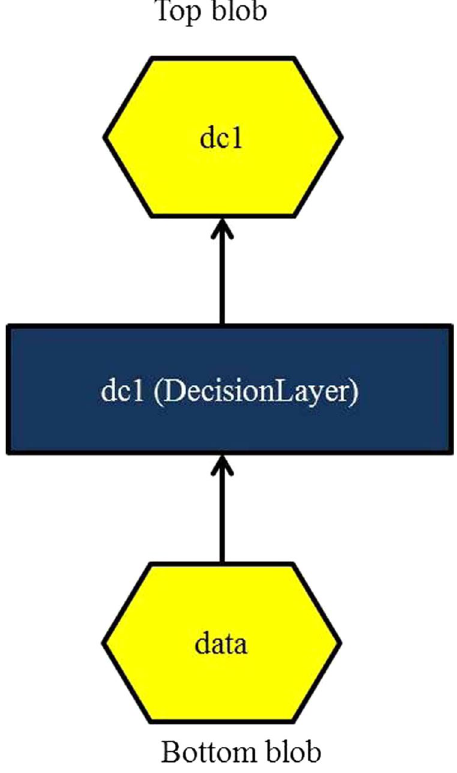
Figure 2. Shows pictorial representation of decision layer connections in CAFFE.